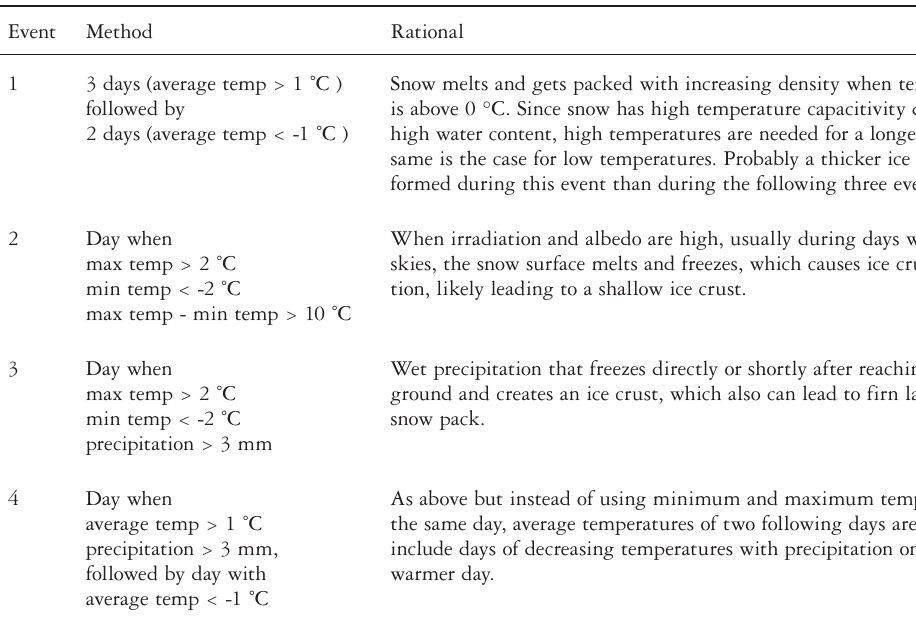
Table 3. Description of weather events assumed to create a high probability of ice crust